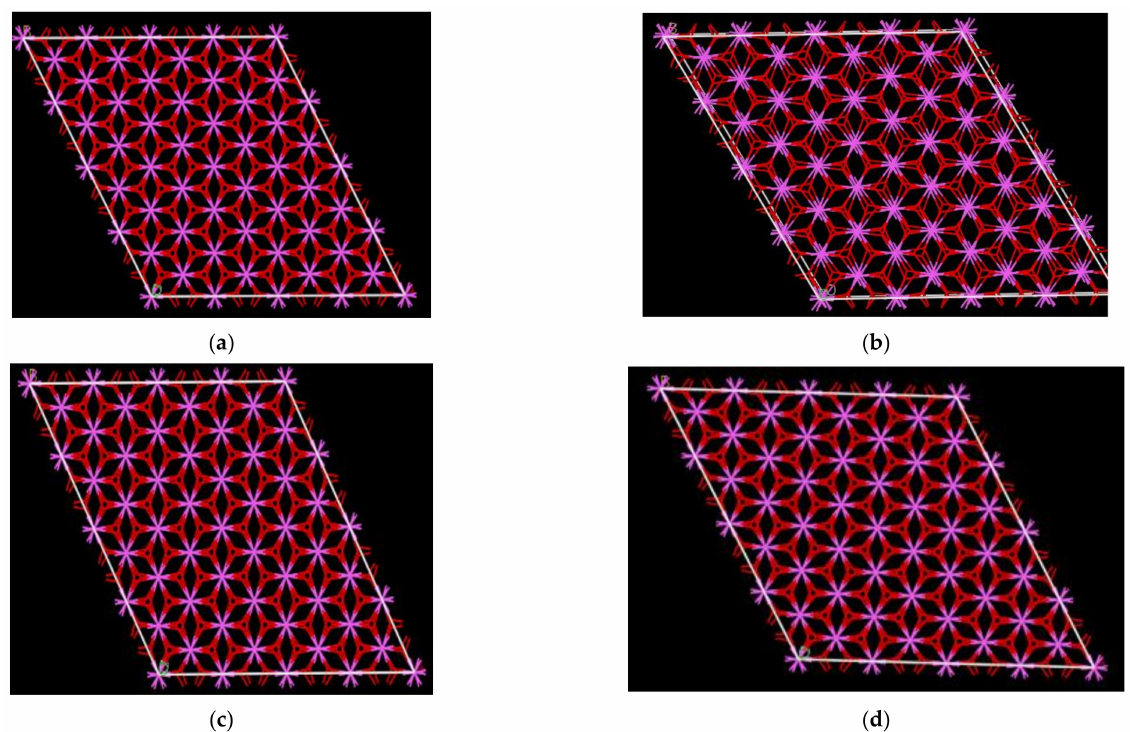
Figure 2. The change graph of the alumina unit cell. ( a ) The simulation graph at low temperature and low electric field intensity; ( b ) the simulation graph at low temperature and high electric field intensity; ( c ) the simulation graph at high temperature and low electric field intensity; ( d ) the simulation graph at high temperature and high electric field